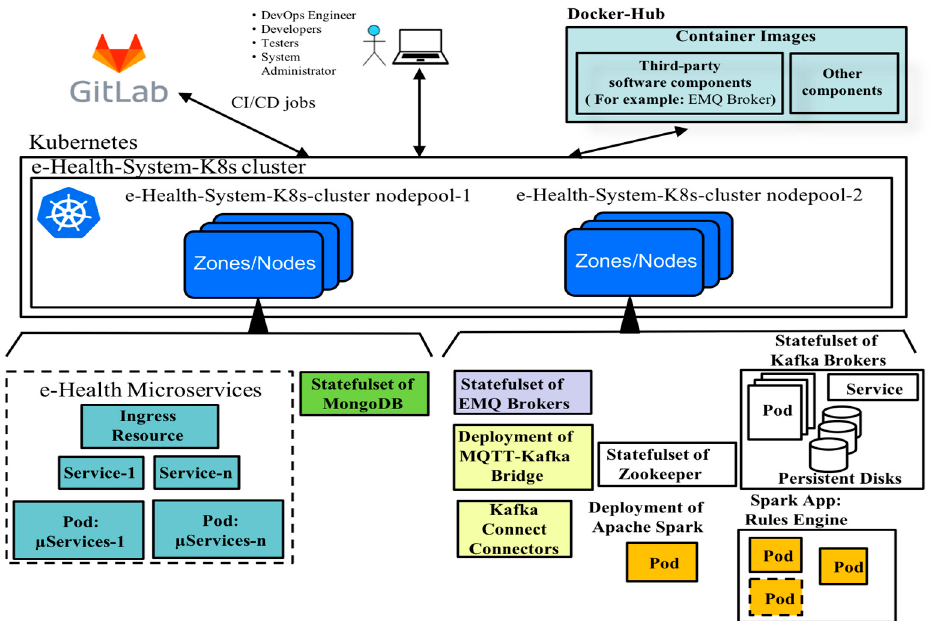
Figure 8. Deployment view.